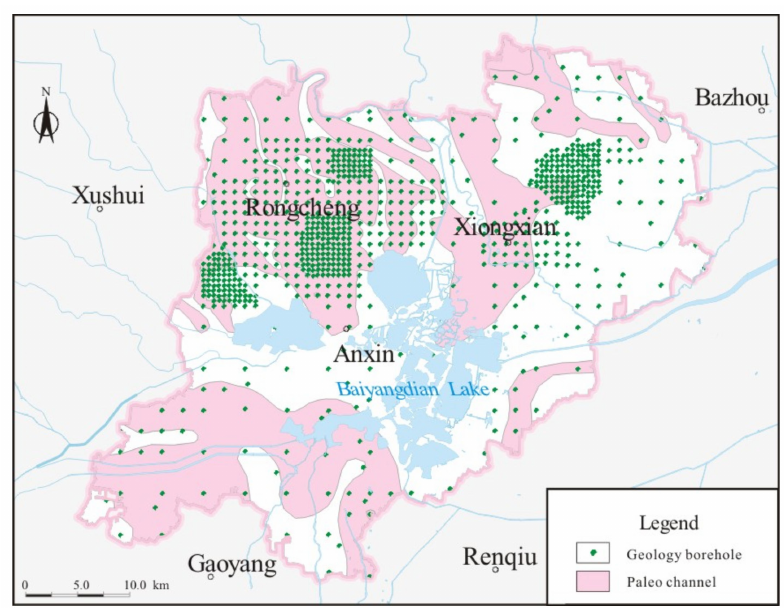
Figure 2. Pleistocene paleo-channel distribution map inferred by